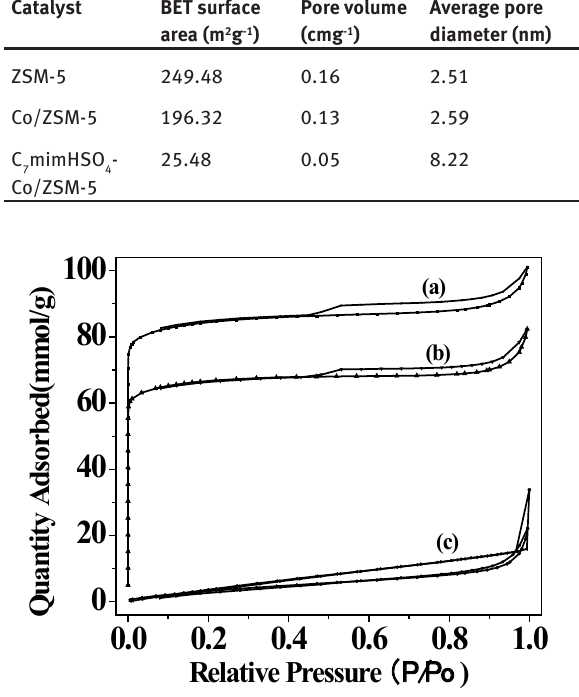
sorption isotherms of (a) ZSM-5, (b) Co/ZSM-5 and (c) Figure 3: N 2 C mimHSO -Co/ZSM-5. 7 4